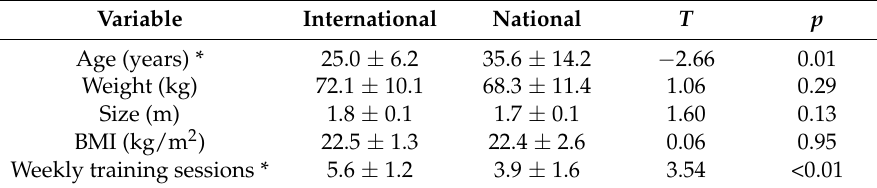
Table 1. Descriptive values of international-level and national-level players.